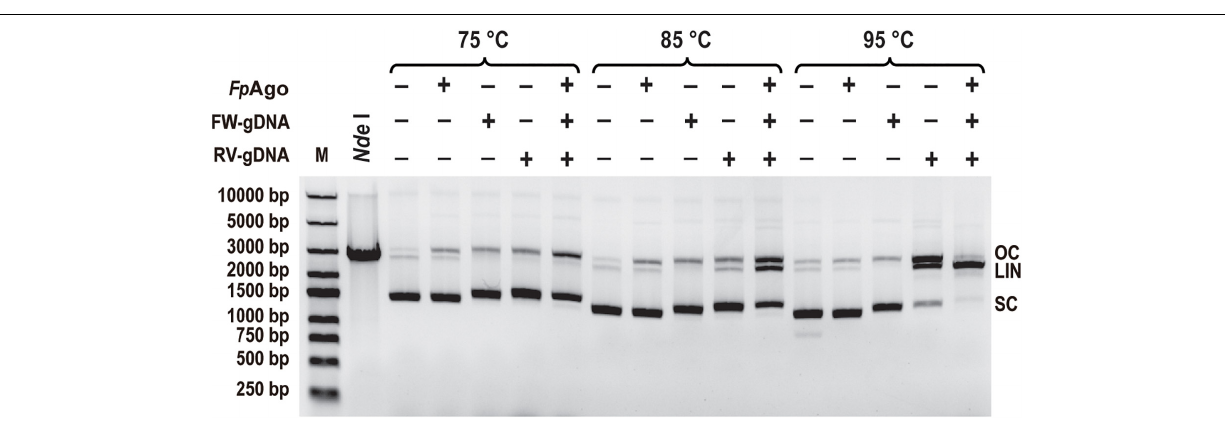
FIGURE 7 | Plasmid cleavage by Fp Ago. Fp Ago-mediated plasmid cleavage after incubation for 15 min at different temperatures. Nde I lane: The extracted plasmid was digested with Nde I for 2 h, followed by 1% agarose gel electrophoresis. FW/RV-gDNA, forward and reverse guide DNA corresponded to a target site in plasmid pUC19; SC, supercoiled plasmid; LIN, linearized plasmid; OC, open circular